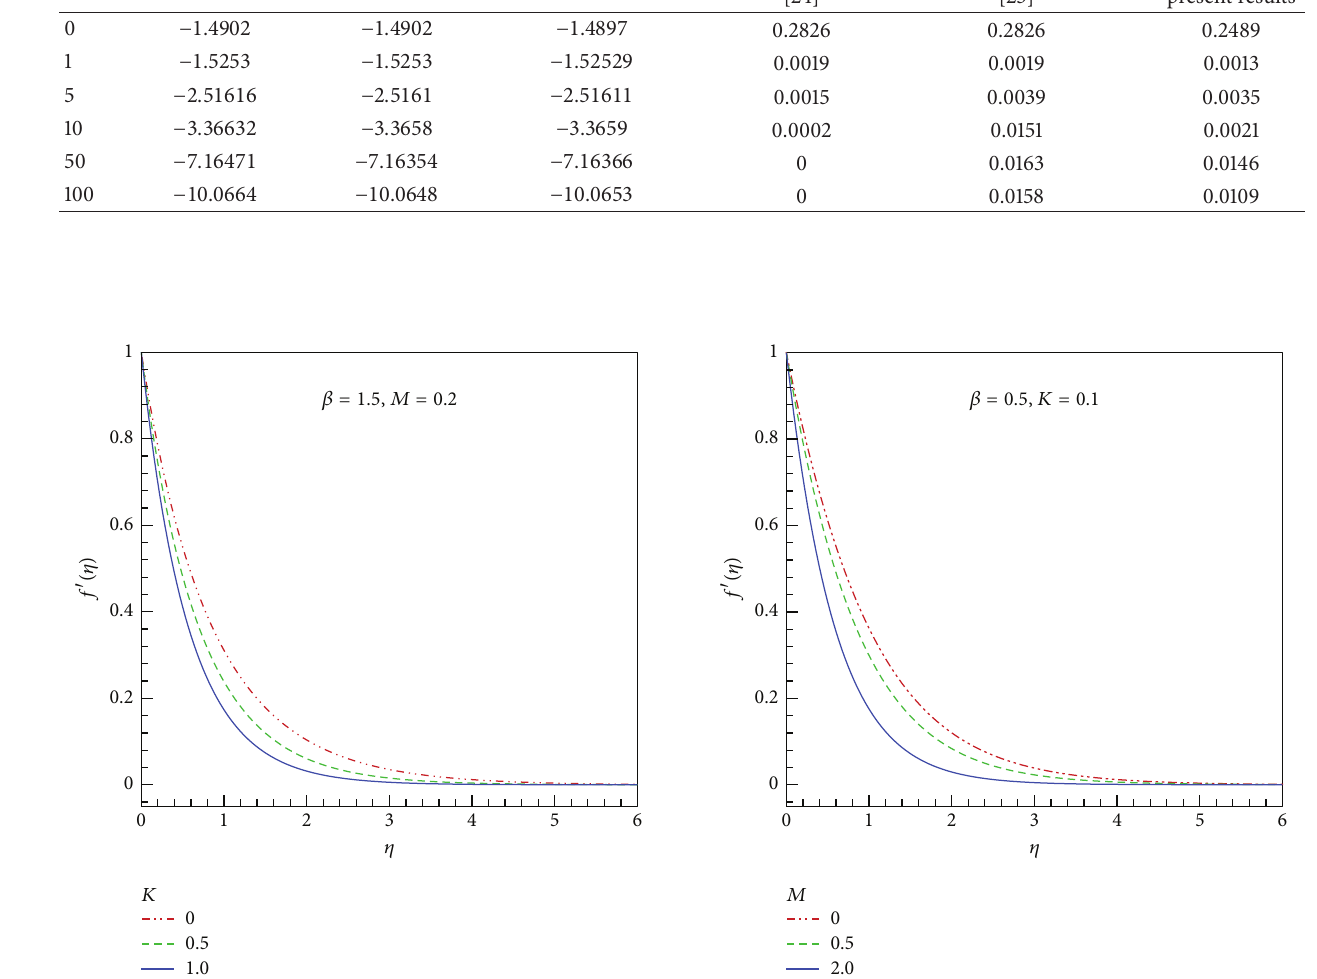
Figure 1: Effect of wall mass transfer parameter on dimensionless velocity for 𝛽 = 1.5 , 𝑀 = 0.2 .